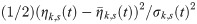
Fitting of experimental data (P1, Model 1).Subplots show the measured and predicted species abundance in the microbial community. The subplots on the diagonal show fitting for mono-species experiments. Subplots on the i-th row and j-th column shows fitting for the corresponding pairwise culture (the abundance of species i in the presence of species j). Recipient and donor species are listed in rows and columns, respectively. For each subplot, the y-axis represents the absolute abundance in the community based on relative abundance multiplied by total biomass (OD600) and the x-axis represents the experiment time in hours. Data points are denoted by grey dots and dynamic model trajectories are denoted by solid lines. The data points highlighted with red circles are data points corresponding to the ten largest errors (1/2)(ηk,s(t)−η¯k,s(t))2/σk,s(t)2. The subplots highlighted with red boxes are subplots for the experiments with the ten largest total prediction errors ∑t∈Tk(1/2)(ηk,s(t)−η¯k,s(t))2/σk,s(t)2.